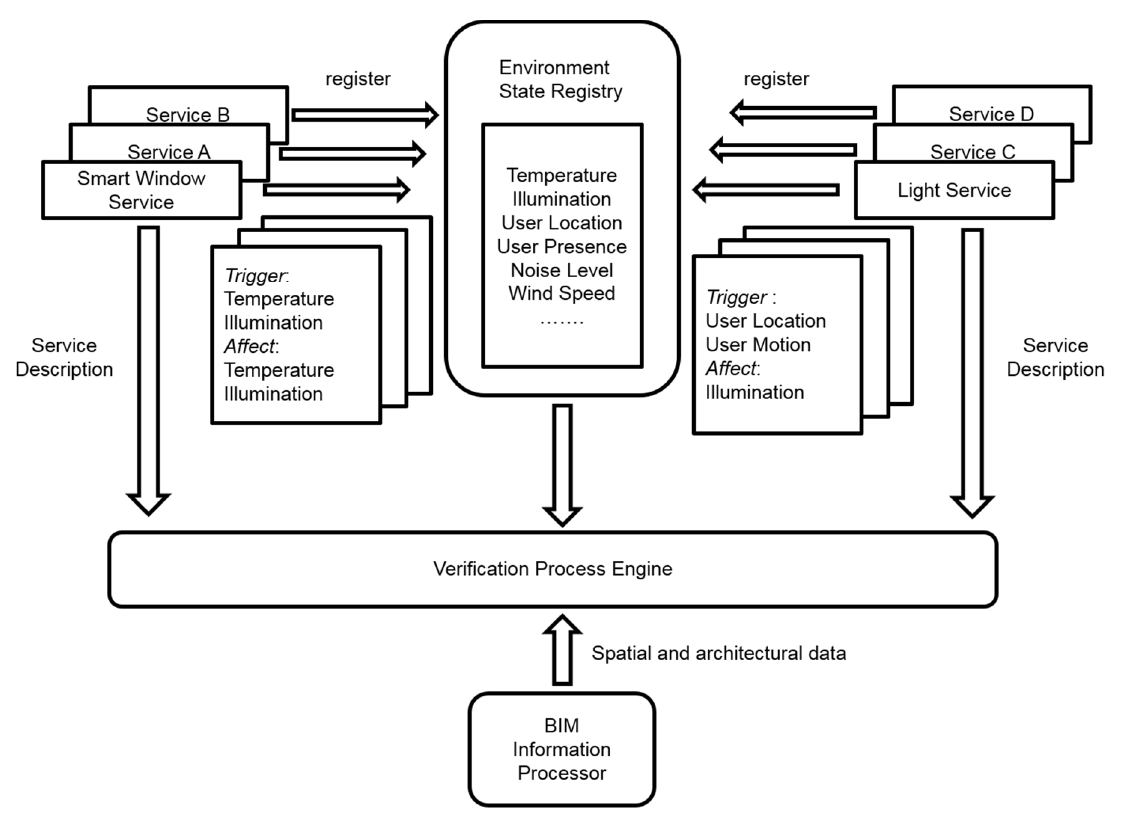
Figure 7. Verification with environment state